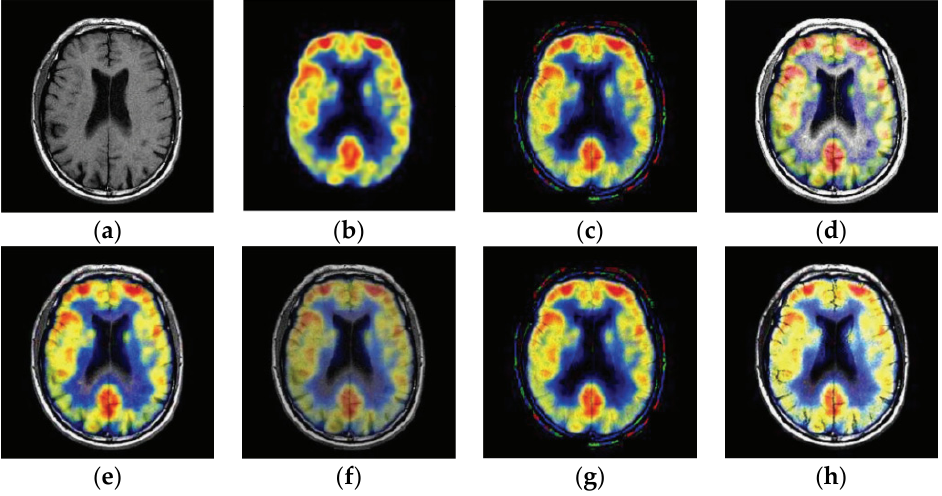
Figure 9. Results of MR-PET image fusion simulation ( a ) MR input, ( b ) PET input ( c ) MCA-CS [14],